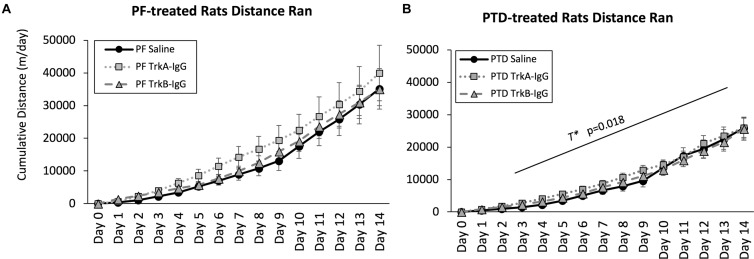
Cumulative distance ran throughout the 2-weeks of wheel running for PF rats (A) and PTD rats (B). Distance traveled is expressed as meters per day ± SEM. PTD rats ran less than control PF rats from days 3 to 14. There were no differences observed in running as a function of blocking BDNF (TrkB-IgG) or NGF (TrkA-IgG). T∗ indicates a significant effect of Treatment.